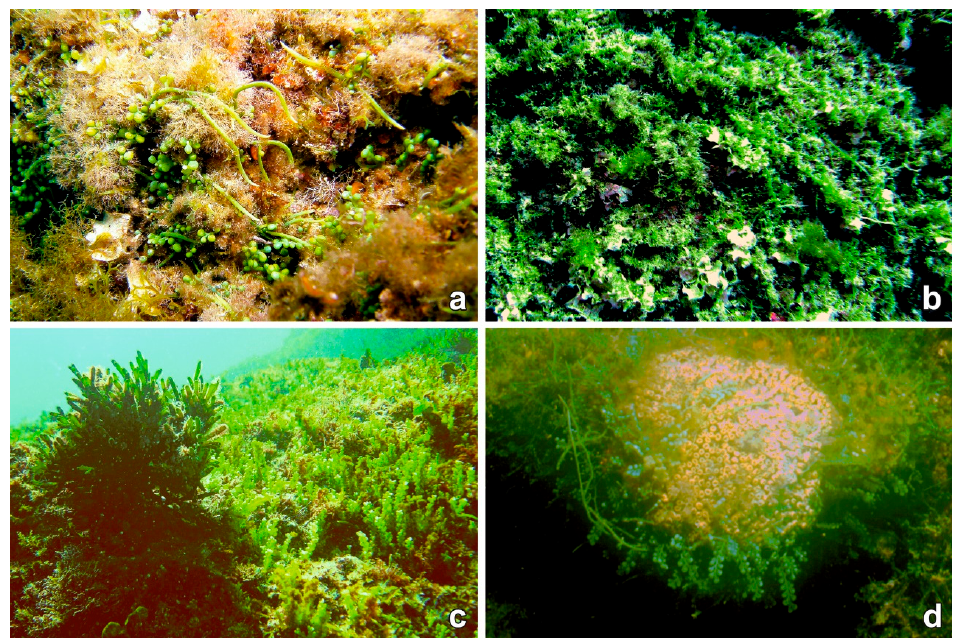
Figure 2. Caulerpa cylindracea Sonder: ( a ) Typical aspect with creeping and jutting stolons and clavate branchlets; ( b ) exhibiting high cover (22%) amid infralittoral algae in shallow water; ( c ) invading the Codium vermilara association (EUNIS A3.231); ( d ) overgrowing a partially bleached colony of the zooxanthellate coral Cladocora caespitosa (EUNIS A3.238).